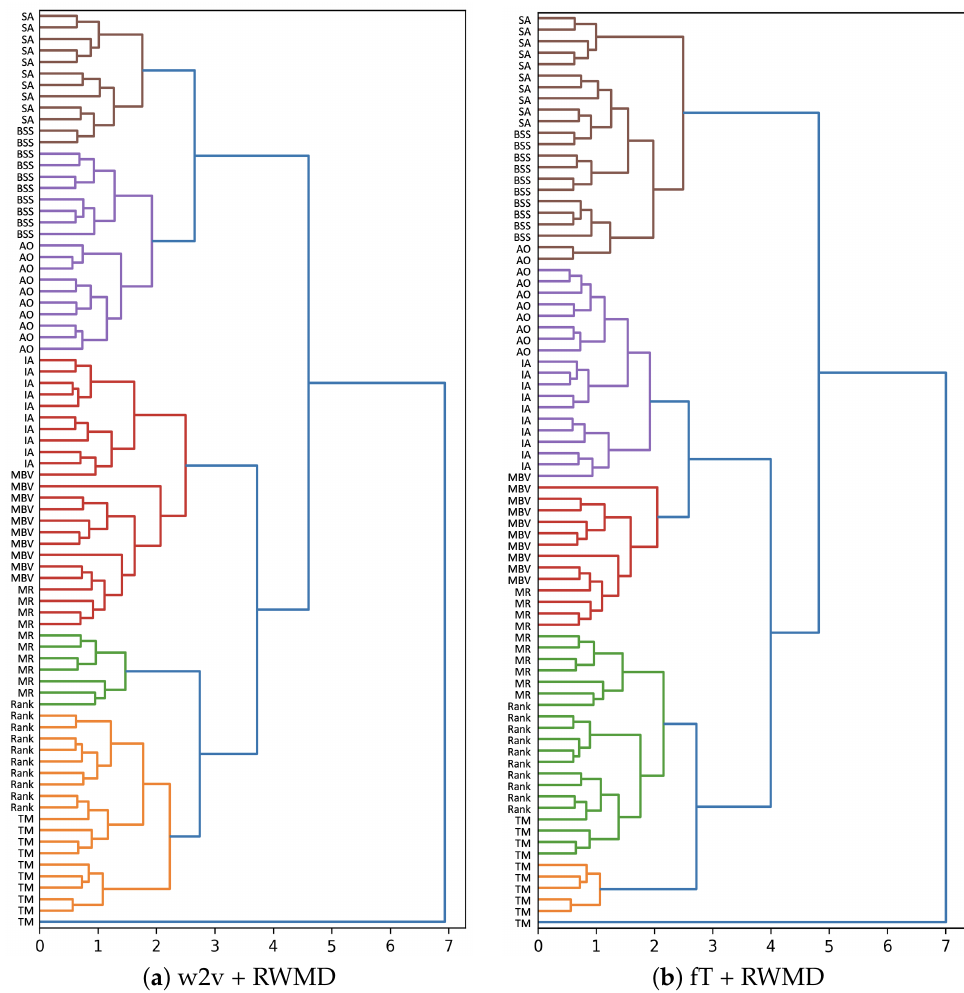
Figure 8. Task II. Clustering using w2v + RWMD and fT + RWMD shows less consistency in clustering: some groups are broken and grouped with other ones (e.g., TM or MR). Colors are assigned automatically by the dendrograms drawing algorithm. The threshold could be